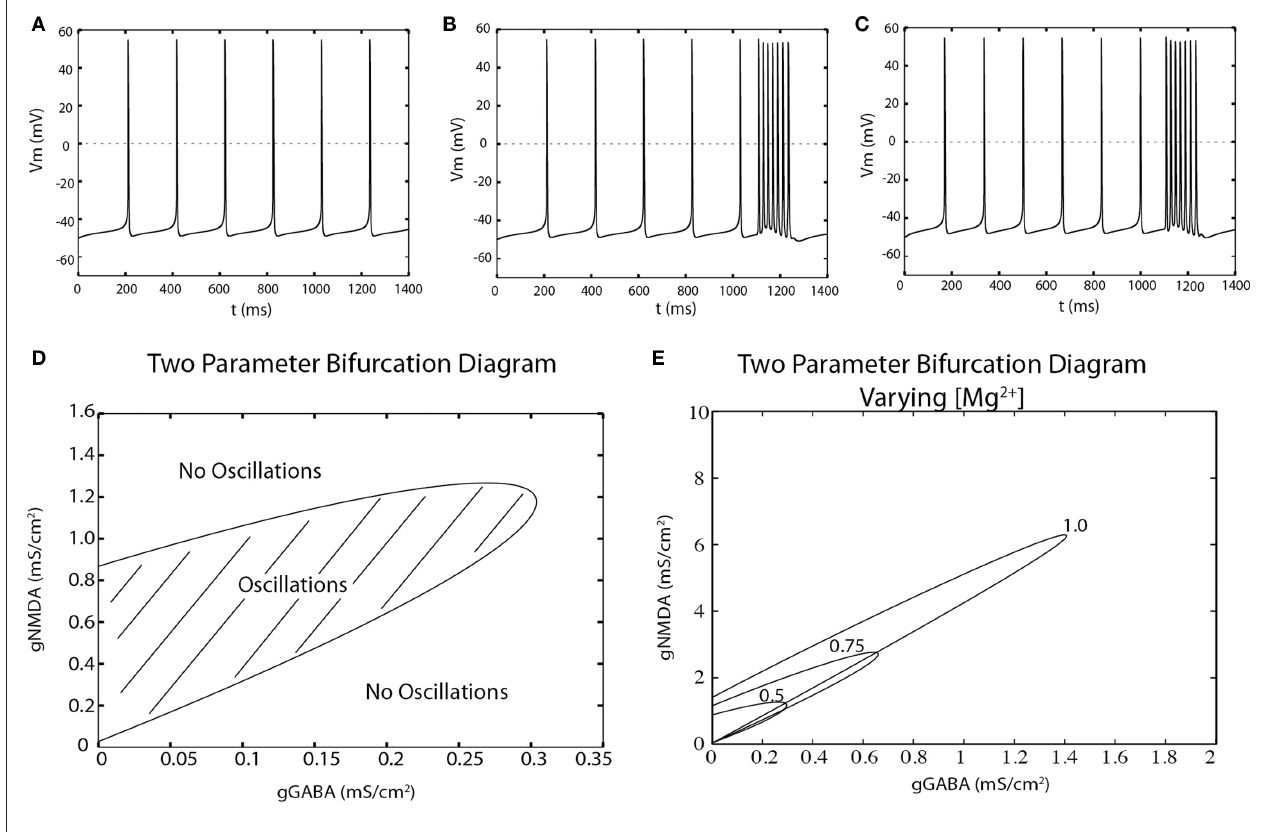
produces bursts by disinhibition upon complete removal of tonic inhibition at t = 1100 ms for 150 ms. (D) The NMDA and GABA conductances at which A repetitive spiking can be generated (hatched region) is computed by a two-point bifurcation diagram in AUTO (XPPAUT). (e) Magnesium dependence of the